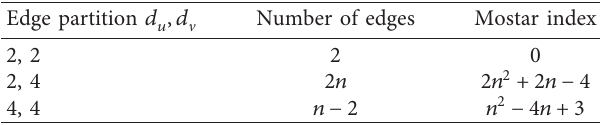
Table 6: Edge partition of oxide network of odd order. Edge partition d u , d v Number of